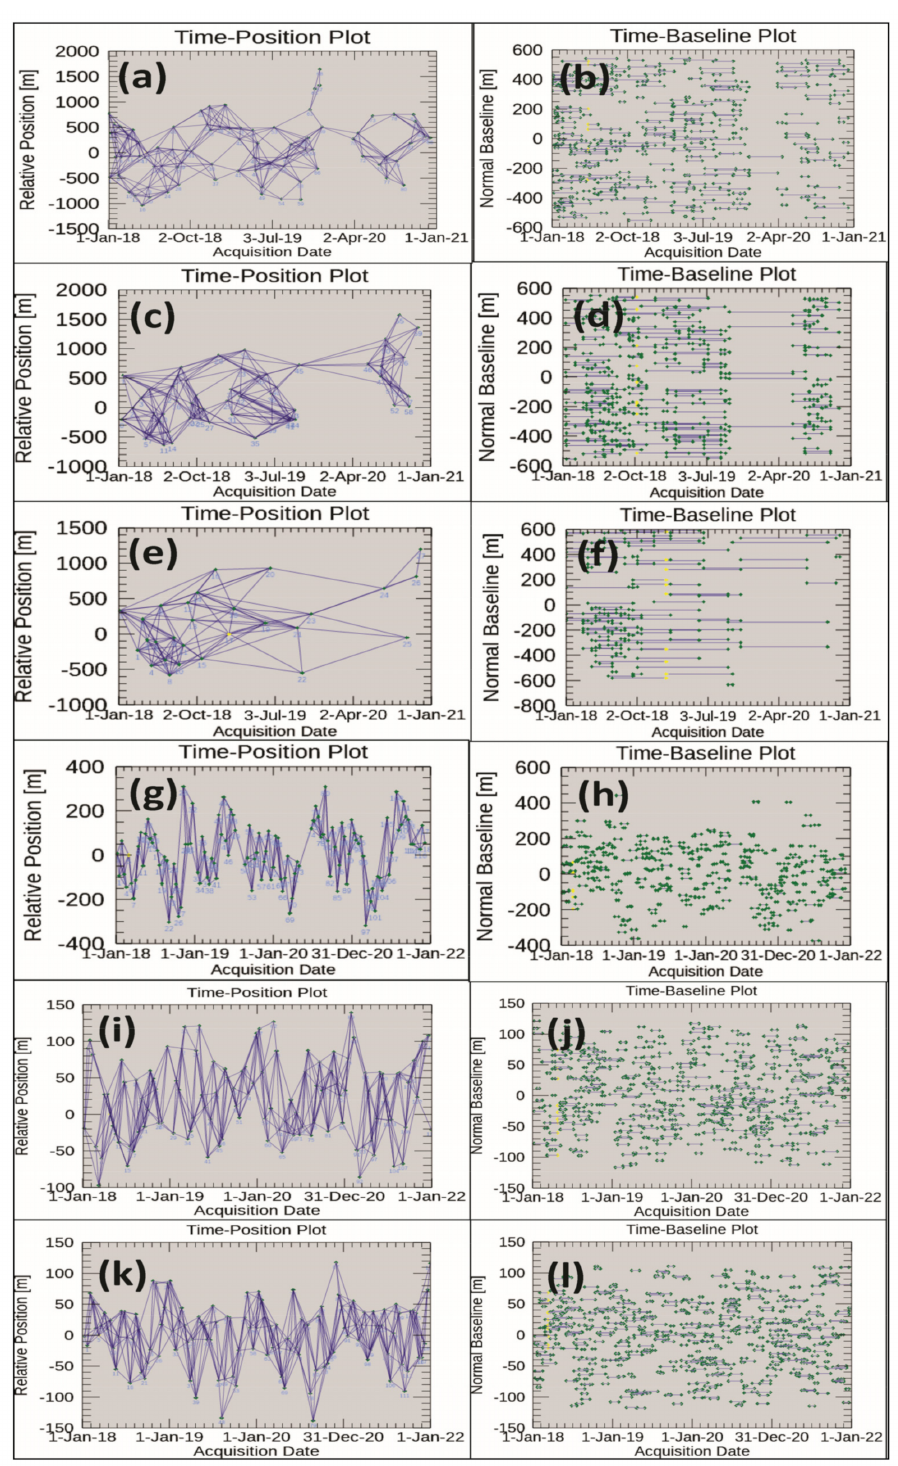
Figure 3. Connection graphs: time-position plot for SBAS and time-baseline plot for SBAS: ( a , b ) CSK DSC; ( c , d ) CSK ASC Right Track; ( e , f ) CSK ASC Left Track; ( g , h ) TSX ASC; ( i , j ) SNT1 DSC; ( k , l ) SNT1